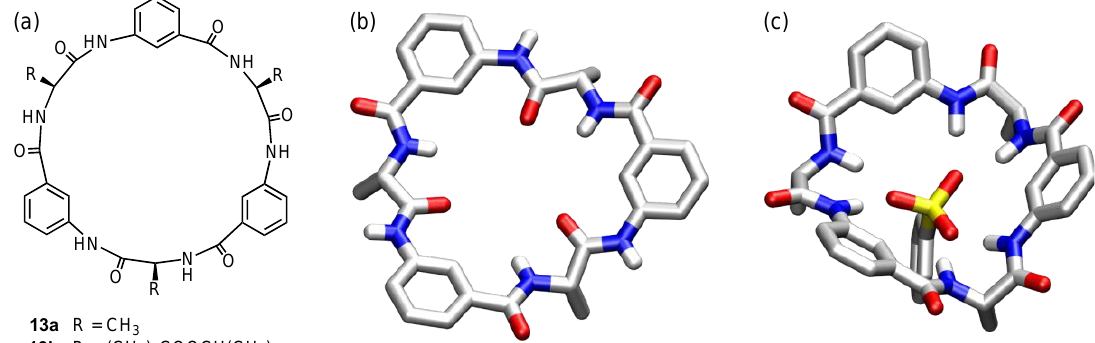
Figure 7. Structures of the cyclic peptides 13a , b ( a ), crystal structure of 13a (CSD Entry: XEHMUW) ( b ), and calculated structure of the benzenesulfonate complex of 13a ( c ). The calculations were per- formed by the author of this review based on the reported results by using Spartan 20 Wavefunction, Inc., Irvine, CA, USA) and the MMFF force-field (see Supporting Information). Solvent molecules, counterions, and protons, except acidic ones, are omitted for reasons of clarity.